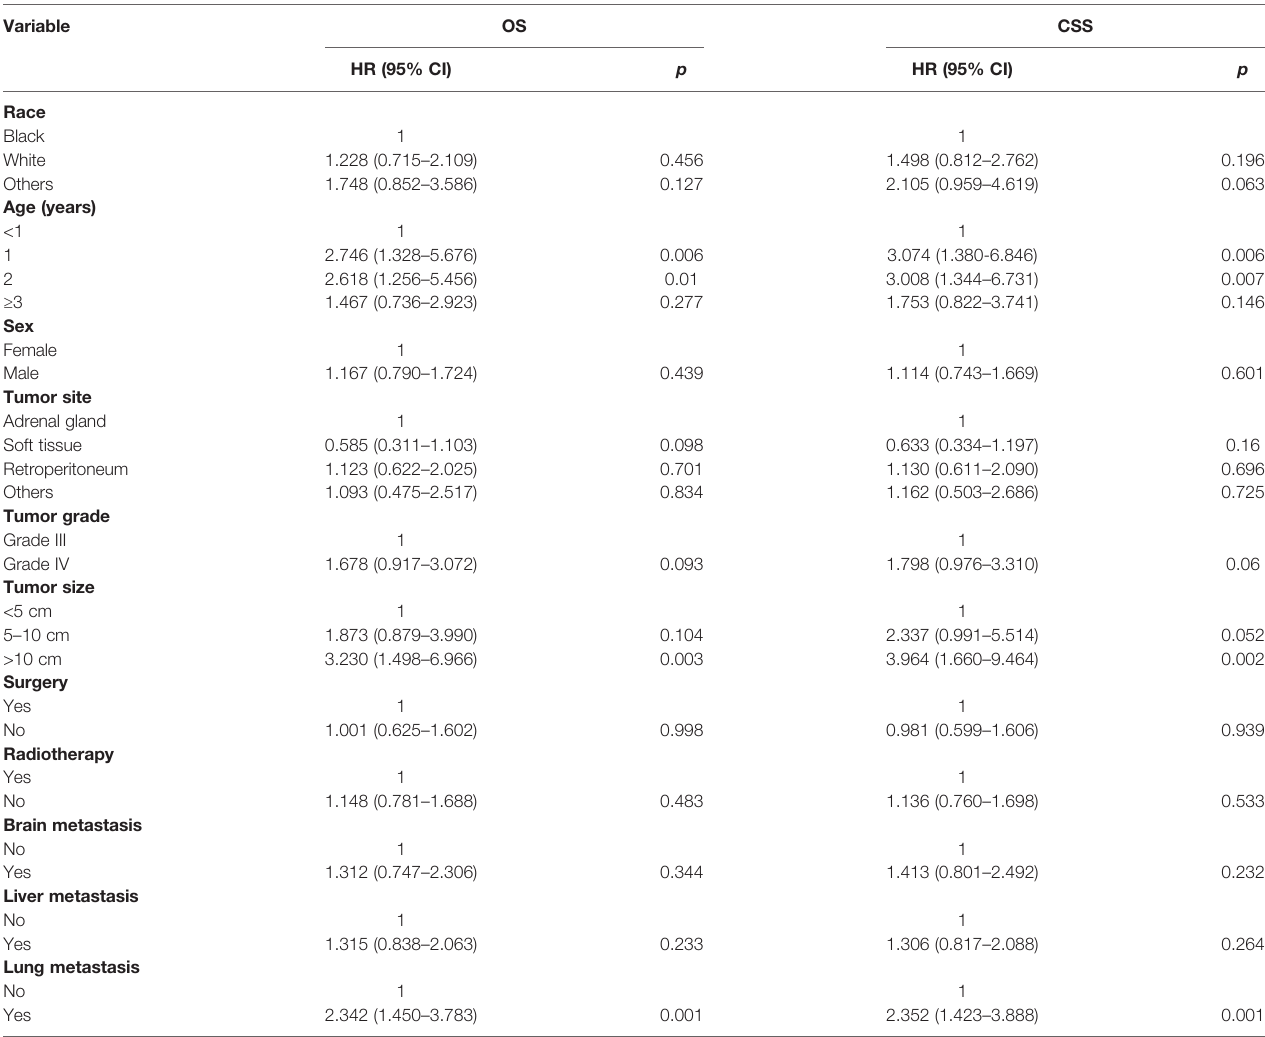
TABLE 2 | Univariate Cox analysis of variables in NB patients with bone metastasis at